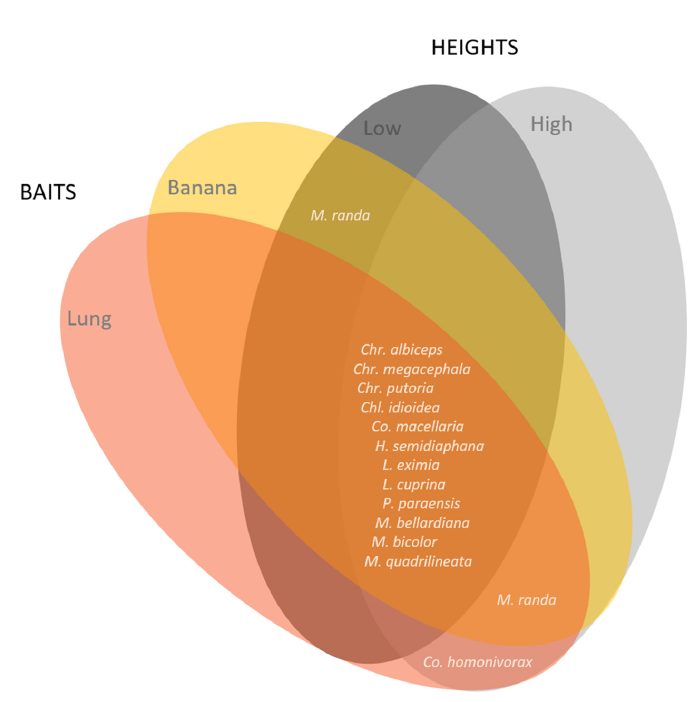
Figure 5. Venn diagram containing the variation of Calliphoridae and Mesembrinellidae species collected in two baits (bovine lung and banana) and two heights (low and high) in the municipality of Mazagão, Amapá State,